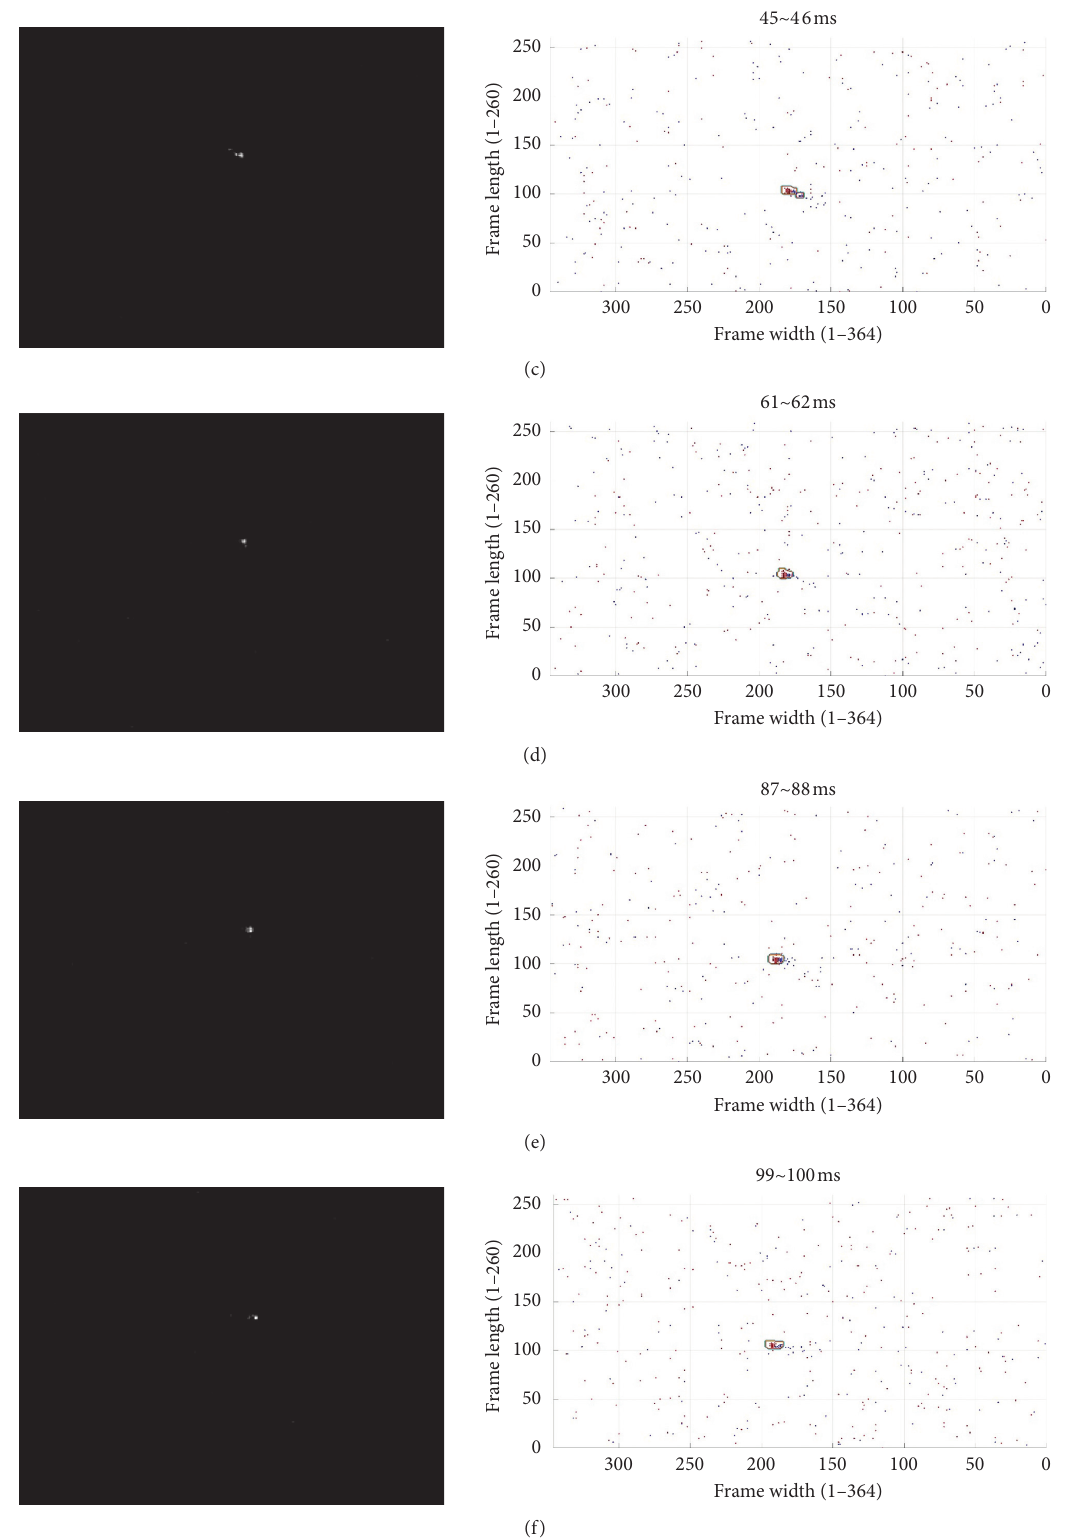
Figure 3: Event correlation index diagrams for some time periods (left) and 3D spatiotemporal diagrams of event flow (right). These figures are visualizations of the event streams in six time periods, and the black boxes in the right figures mark the outline information of the